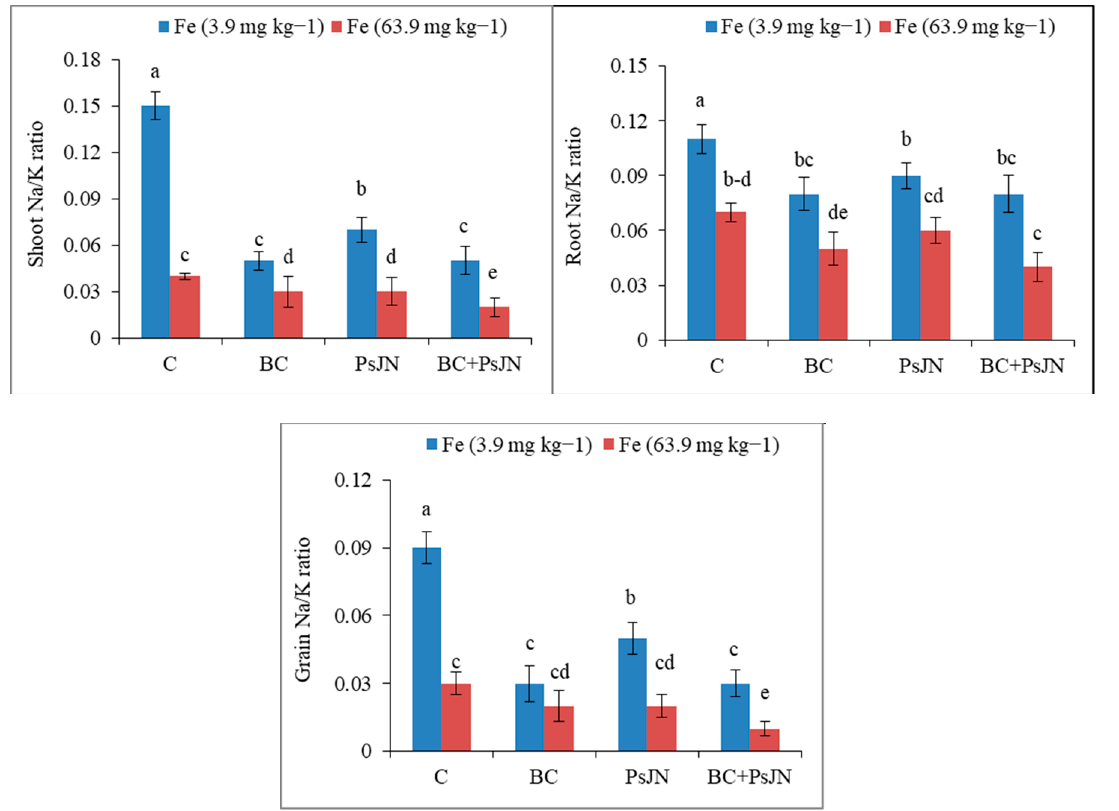
Figure 2. The effect of biochar- Burkholderia phytofirmans PsJN integration on Na/K ratio of Chenopodium quinoa tissues under salinity stress. Quantities sharing similar letters are not different with each other. C: Control; BC: Biochar (1% w / w ); PsJN: Burkholderia phytofirmans ; Fe: Ferrous sulphate (15 kg ha − 1 ). Values are mean of three repeats ± SD.